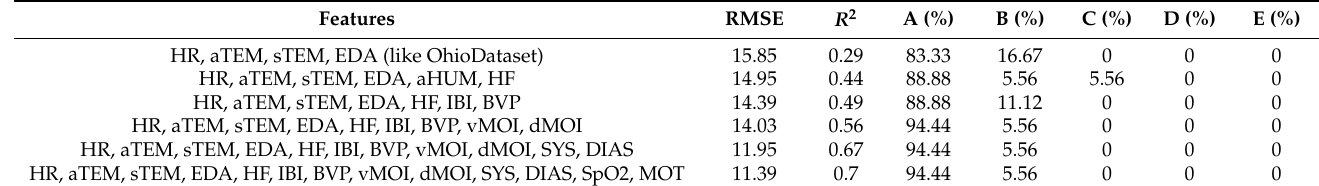
Table 7. Performance of the best-trained bagged tree model in unseen instances versus different noninvasive features for Subject 2 from the UofM